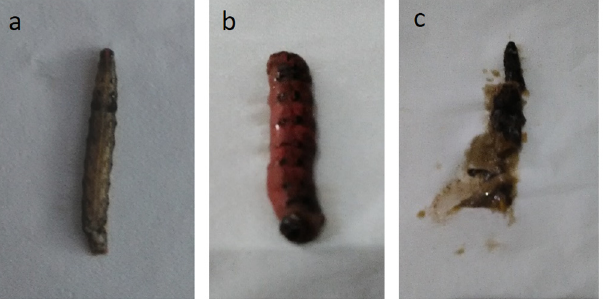
Figure 5. Larvae cadaver profile, ( a ) non-infected Spodoptera litura , ( b ) Spodoptera litura infected by Helicoverpa armigera nuclear polyhedrosis virus subcultured ( Ha NPV 1 ), and ( c ) infected larval flaccid with blackish color and stinky.